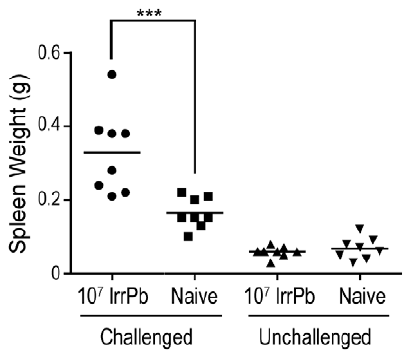
Figure 5. Spleen weights of mice immunized with IrrPb increase during a virulent infection. C57BL/6 mice were immu- nized once with 10 7 IrrPb, challenged with virulent parasites, and then spleens were harvested on day 6 after challenge. Spleens from immunized mice after challenge were an average 0.17 grams (0.09, 0.24) larger than the spleens from naı¨ve mice after challenge (two-sided p , .001, Two Way ANOVA, Bonferroni post test). Results (n=8 mice in each group) are pooled from two independent experiments.